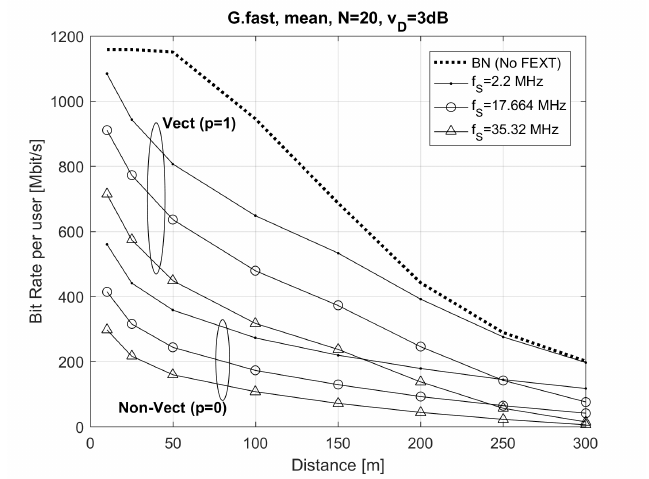
Figure 10. G.fast bit rate vs. distance for f S = 2.2 MHz, f S = 17.664 MHz, and f S = 35.32 MHz.